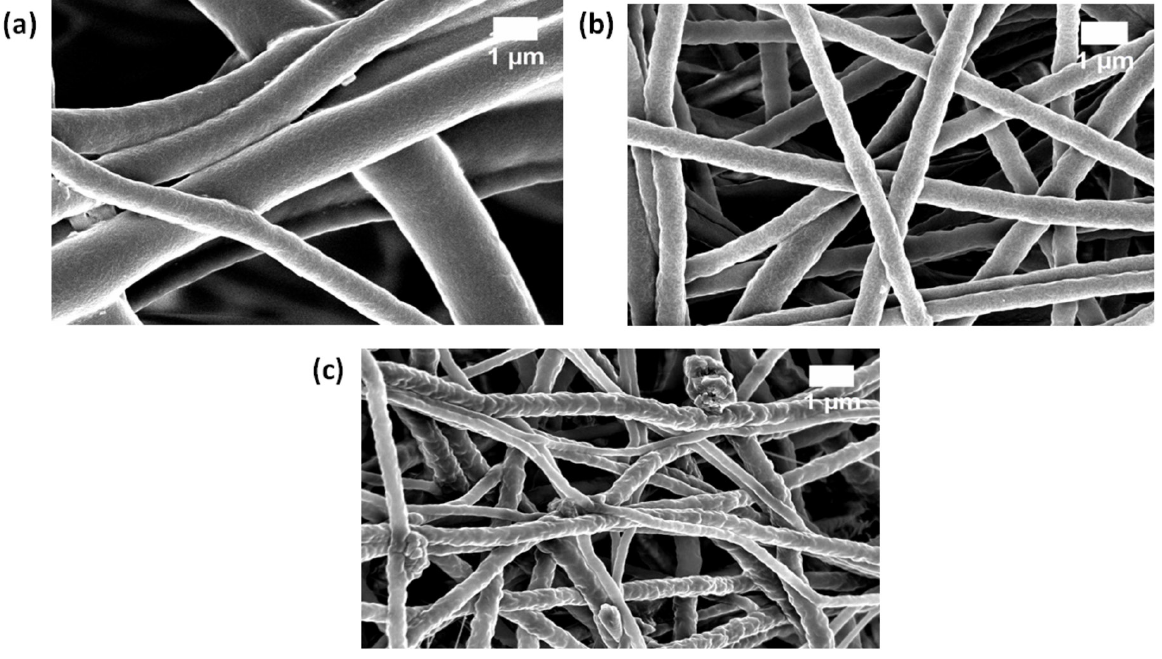
Figure 1. FESEM images of a) PU, b) PU/BB and c) PU/BB/CONO